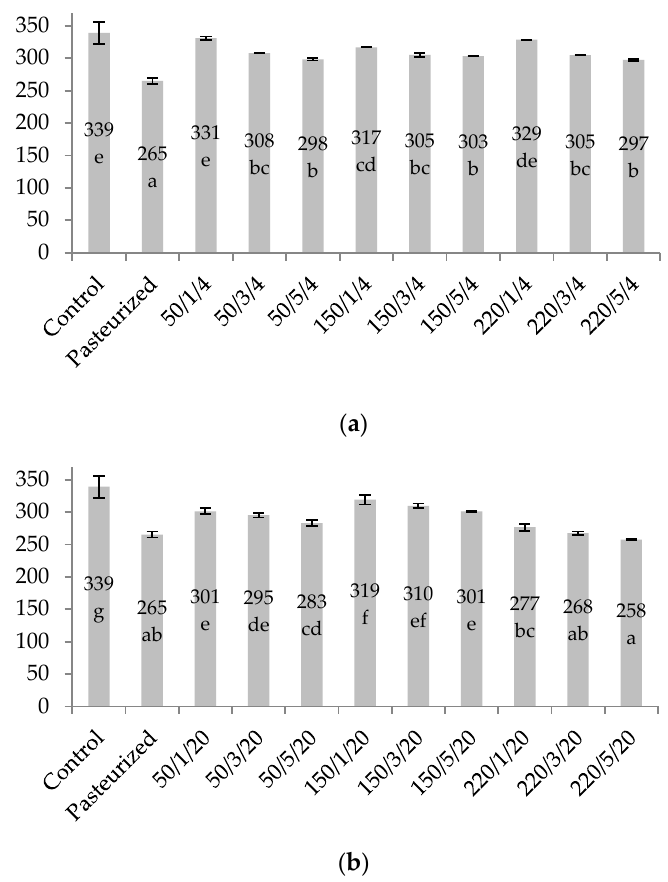
Figure 3. Total phenolic content (mg GAE/100 mL) determined in cloudy blackcurrant juice treated with high-pressure homogenization or pasteurization. Samples were labelled as level of pressure/number of passes/inlet temperature. ( a ) HPH samples with the inlet temperature of 4 ◦ C; ( b ) HPH samples with the inlet temperature of 20 ◦ C. The values with different superscript letters (a–e) are significantly different ( p < 0.05). Statistics were performed separately for figure ( a ) and figure ( b